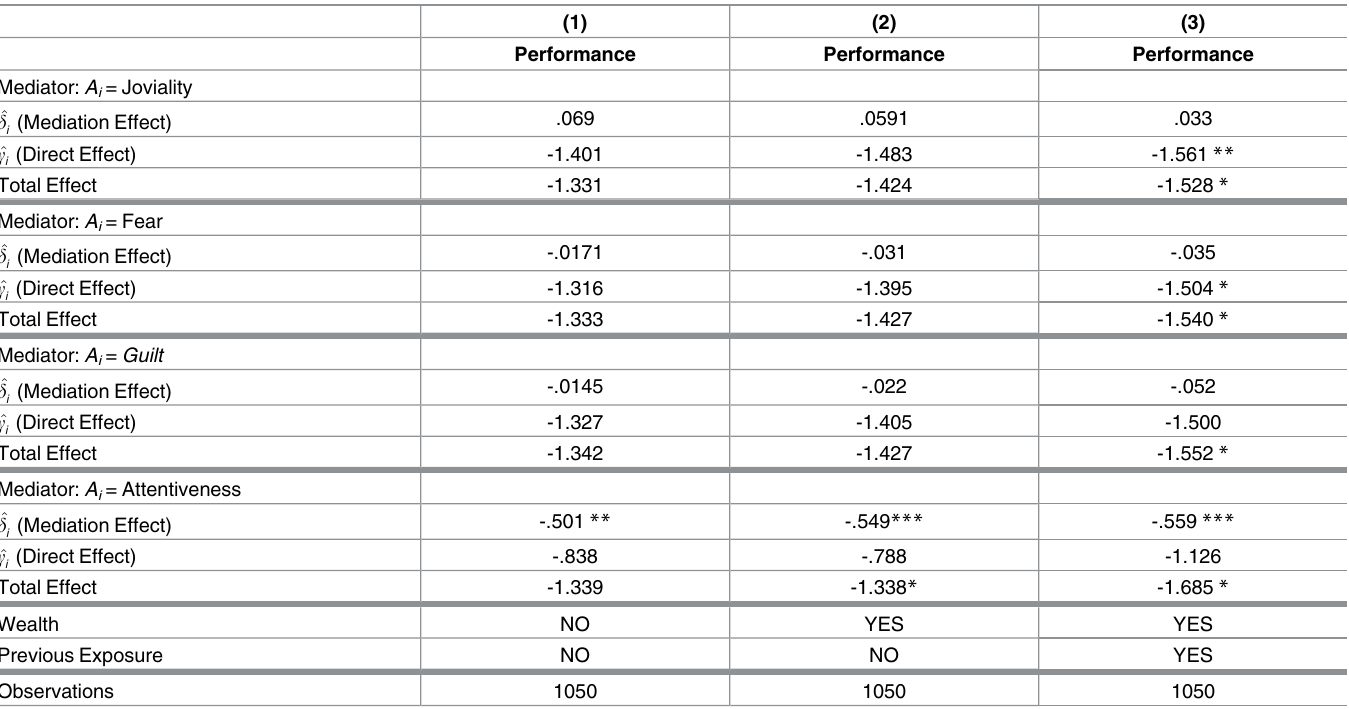
Table 9. Mediation Analysis for Self-Reported Affect